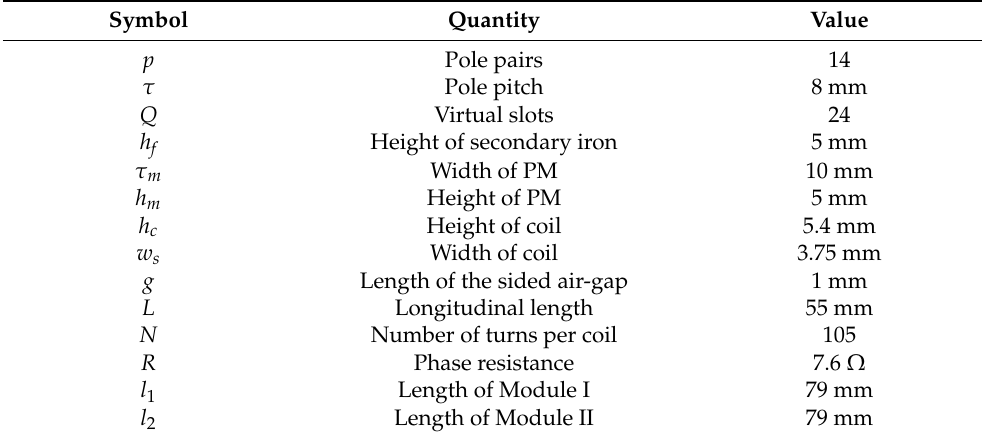
Figure 2. Configuration of the proposed two-module PMLSM. ( a ) The 24s/28p structure diagram. ( b ) Winding connections of the 24s/28p structure. Table 1. The main parameters of the 24s/28p PMLSM.